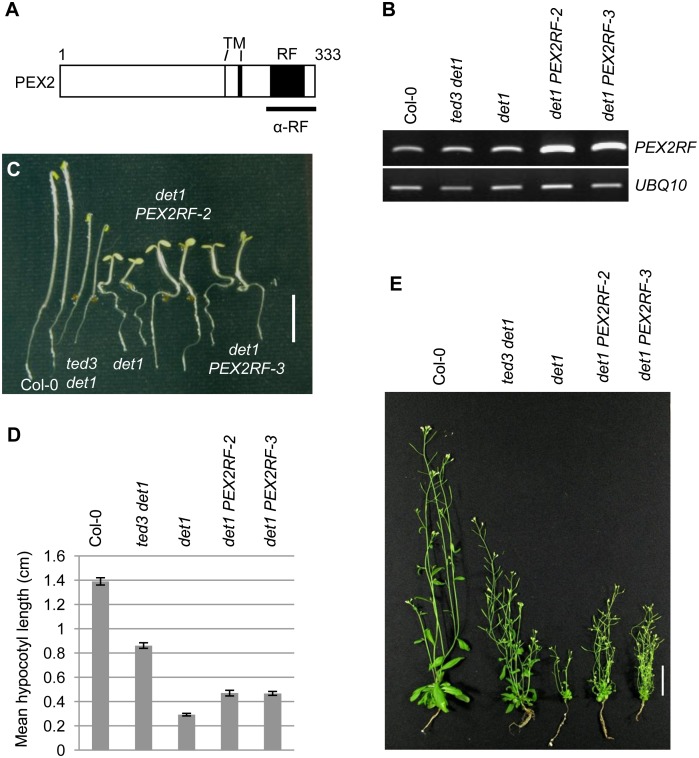
Overexpression of a peptide that contains the PEX2 RING domain suppresses det1.(A) Schematic of the Arabidopsis PEX2 protein, showing positions of the transmembrane (TM) and RING finger (RF) domains, and the region (indicated by horizontal bar) used as PEX2RF and as antigen for antibody generation. (B) RT-PCR analyses of the PEX2RF transcript in two transgenic lines (lines2 & 3) overexpressing PEX2RF in the det1 background. UBQ10 is the internal control. (C) Phenotype of 4d dark-grown seedlings grown on 0.5X MS supplemented with 0.5% sucrose. Scale bar = 0.5 cm. Two seedlings are shown for each genotype. (D) Hypocotyl length measurements of 4d dark-grown seedlings shown in (C). n>30 for each genotype. Student t-test, P<0.0001 for all lines vs. det1. Error bars indicate s.e.m. (E) Four-week plants. Scale bar = 3 cm.